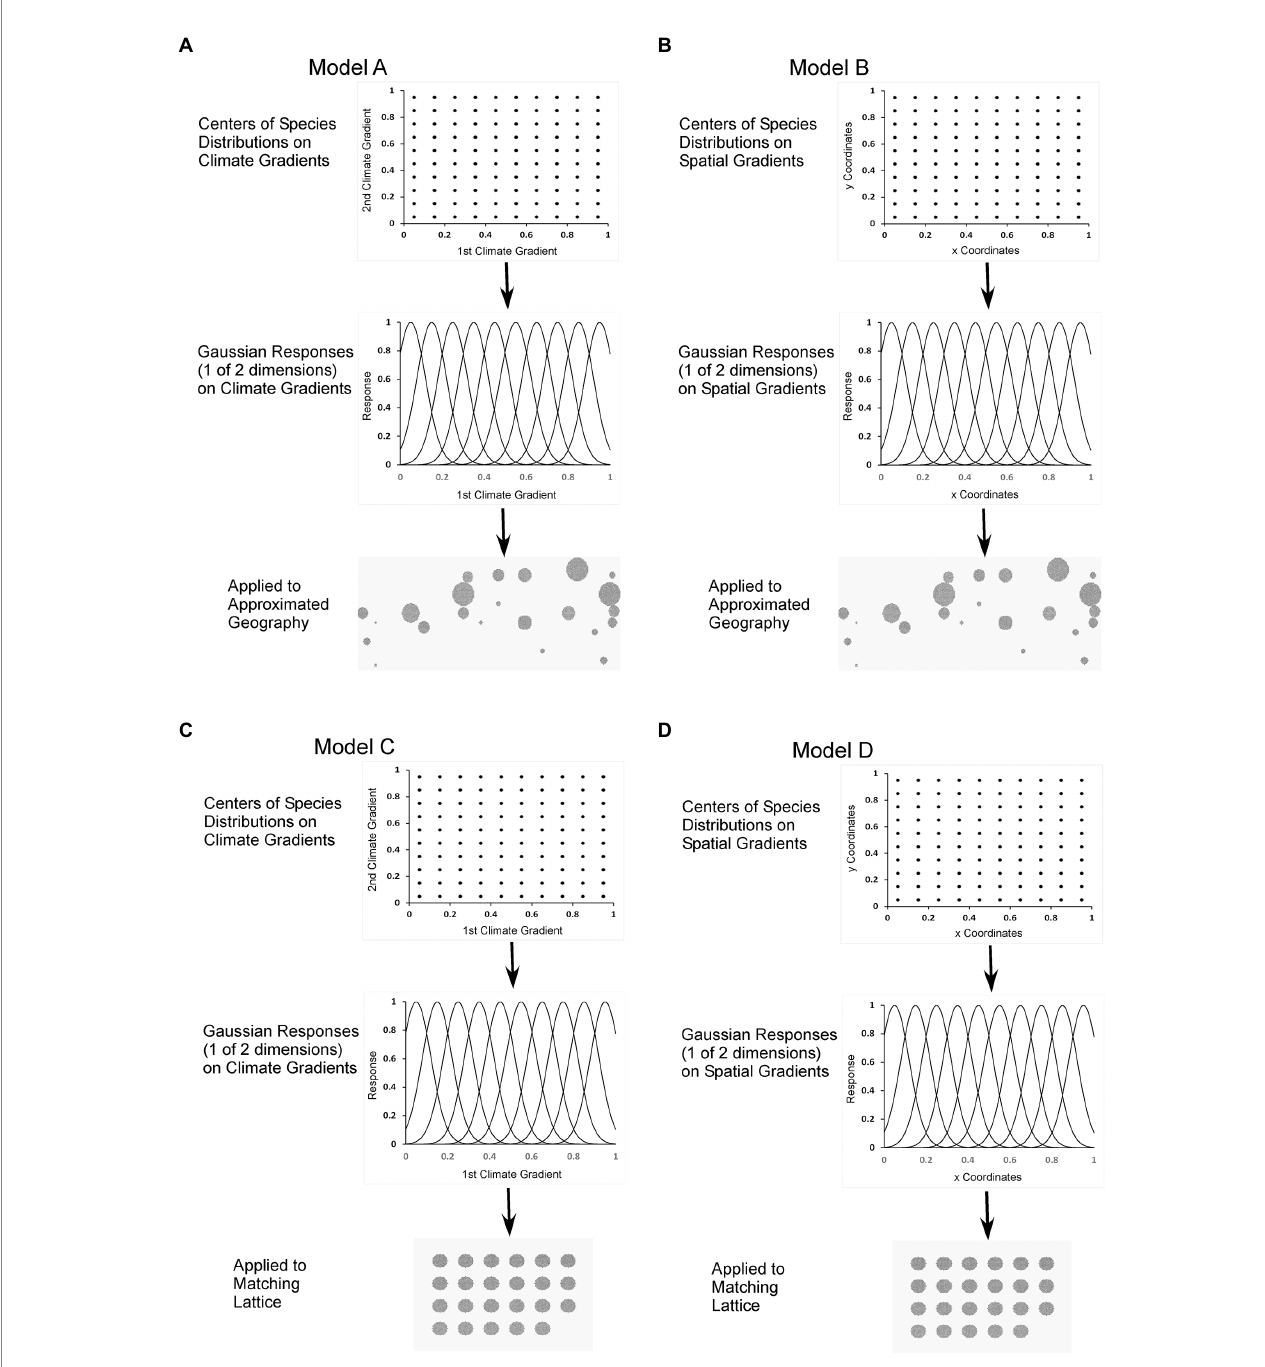
FIGURE 1 The four models (A–D) that were the basis of the simulations. The four models are for two parameterizations of the virtual species (adaptations to climate and to location) and two representations of geography (an approximation of the mountain ranges and a regular lattice). For either two climatic gradients or two spatial gradients (top panels) species adaptations were set as Gaussian response functions (middle panels; single climate and location gradients are shown, but two were used to define 100 virtual species). Simplified geographies and a regular lattice of the same number of ranges of SACEU are shown (bottom panels), but similar constructs for WUSAC were also